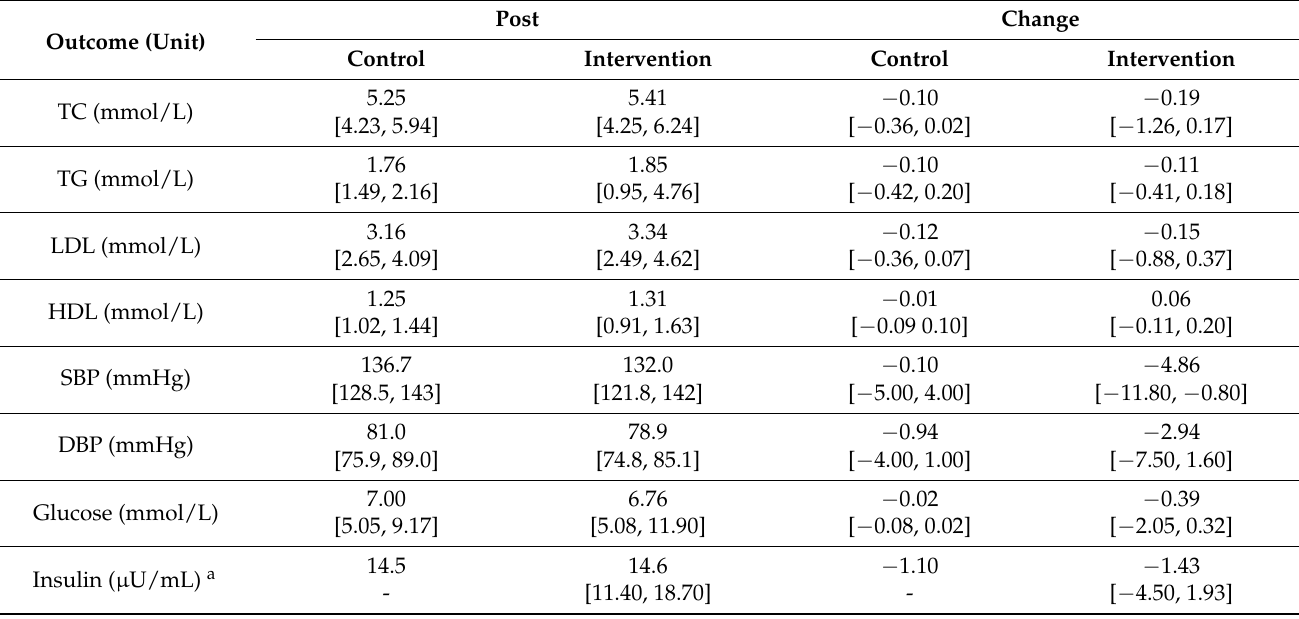
Insulin ( µ U/mL) a